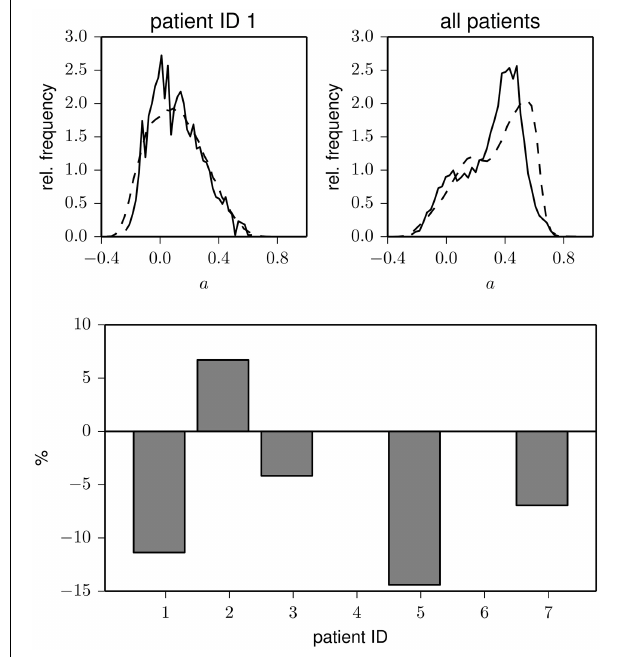
FIGURE 3 | Top: Frequency distributions of the assortativity coefficient derived from data recorded during pre-ictal (solid) and inter-ictal periods (dashed) for one patients (left) and for the pooled data from all patients (right). Bottom: Relative changes of assortativity ( ¯ a pre − ¯ a inter ) / ¯ a inter during pre-ictal and inter-ictal periods for each patient (patients 4 and 6 had no seizures during the recording period). ¯ a inter and ¯ a pre denote median values of the respective